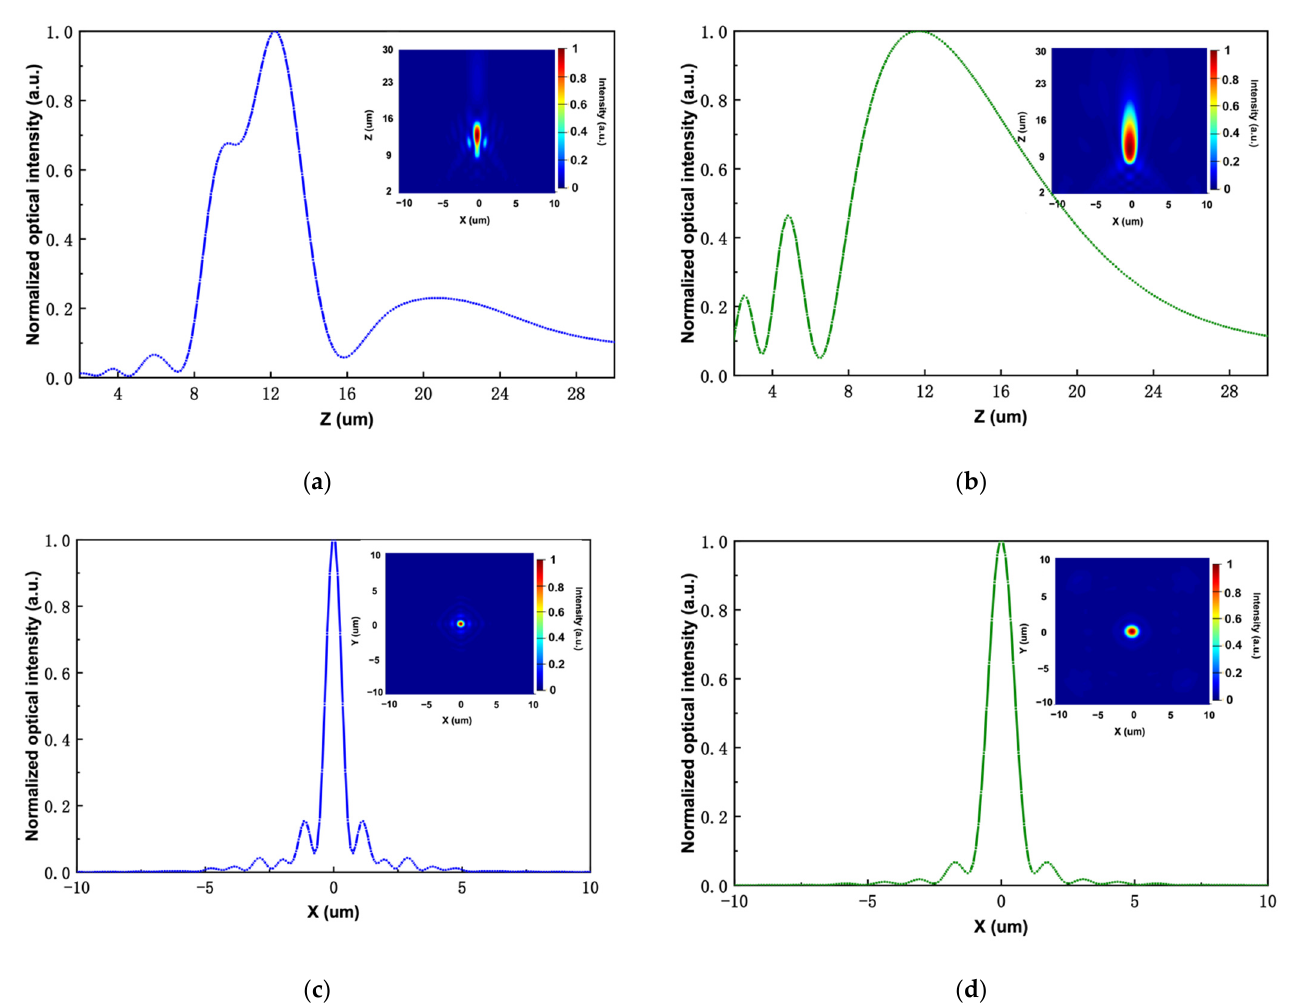
Figure 4. Performance of the dual-wavelength achromatic metalens. ( a , b ) The normalized optical intensity along z -axis at x = 0 and y = 0 with the illumination at 1000 and 1550 nm, respectively. The inset figures represent the normalized optical intensity along the cross section at the x-z plane when y = 0. ( c , d ) The normalized optical intensity along x -axis at the focal plane. The inset figures illustrate the optical intensity at the focal plane.